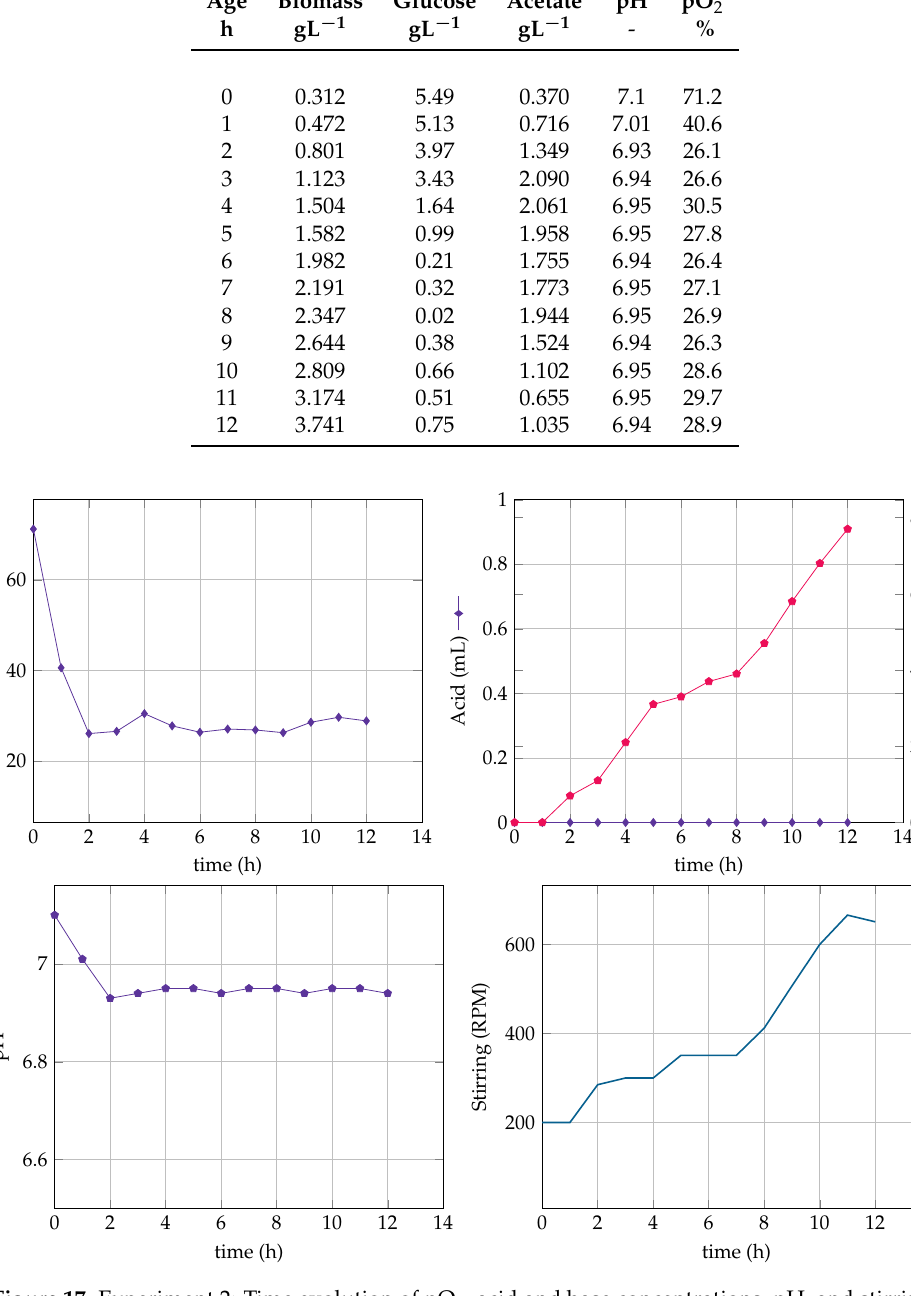
Figure 17. Experiment 2: Time evolution of pO 2 , acid and base concentrations, pH, and stirring. In order to compare the experimental results with the model predictions, a simulation using the nominal model is performed with the reference profile of the first experiment and under the same operating and control conditions (same parameter values). As shown in Figure 19, the ideal model control input F in follows the same tendency as the expertimental